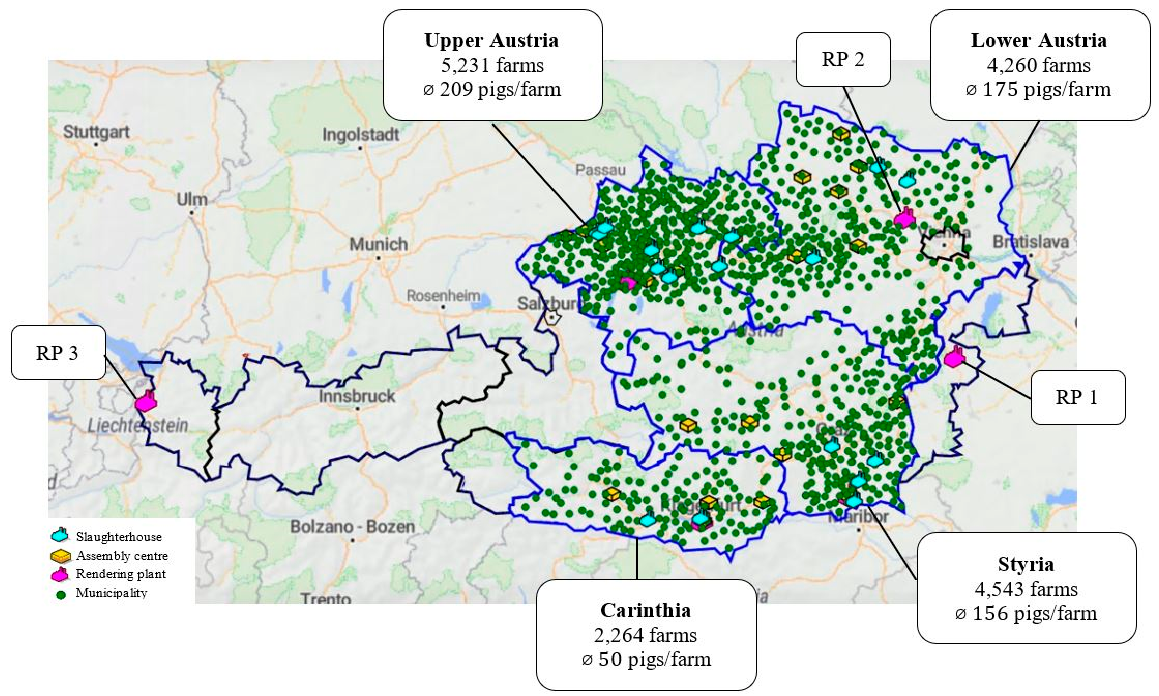
Figure 4. Spatial distribution and figures of domestic pig farms and rendering plants (RP) in selected federal states of Austria.